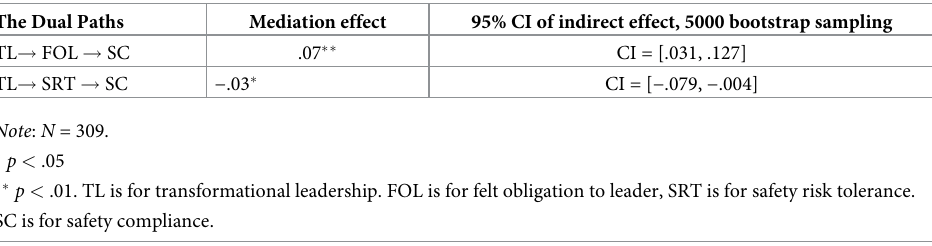
Table 5. Mediation effects of felt obligation to leader and safety risk